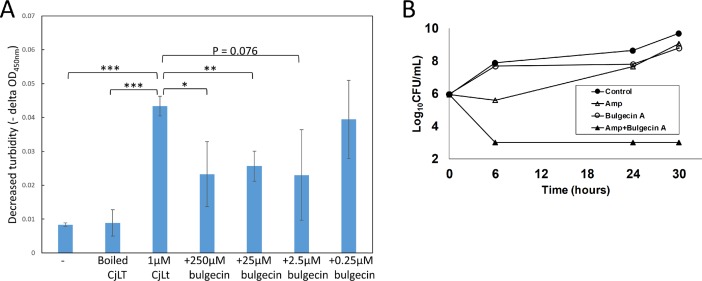
Enzymatic and microbiological assays of Cj0843 with bulgecin A.A Turbidity assay shows inhibition of 1μM Cj0843 by bulgecin A (0.25–250μM). Control experiments include adding no enzyme and boiled/inactivated Cj0843. Data show the mean ± SEM of three independent experiments. *P<0.05, **P<0.01, and ***P<0.001 (Student’s t-test). B Bulgecin A potentiated the efficacy of Amp against β-lactam resistant C. jejuni. A β-lactam resistant C. jejuni strain was inoculated in MH broth (control), or MH broth supplemented with Amp (128 μg/mL, sublethal concentration), bulgecin A (100 μg/mL) or both Amp (128 μg/mL) and bulgecin A (100 μg/mL). The detection limit (dotted line) of the assay is 1 x 103 CFU/mL. Each data point represents the mean ± SEM obtained from duplicate wells in the microtiter plate growth assay. At 30hr, MH vs Amp: P = 0.01; Amp vs Bul: P = 0.04; Bul vs Amp+Bul: P = 0.0001; Amp vs Amp+Bul: P < 0.0001 (Student’s t-test).